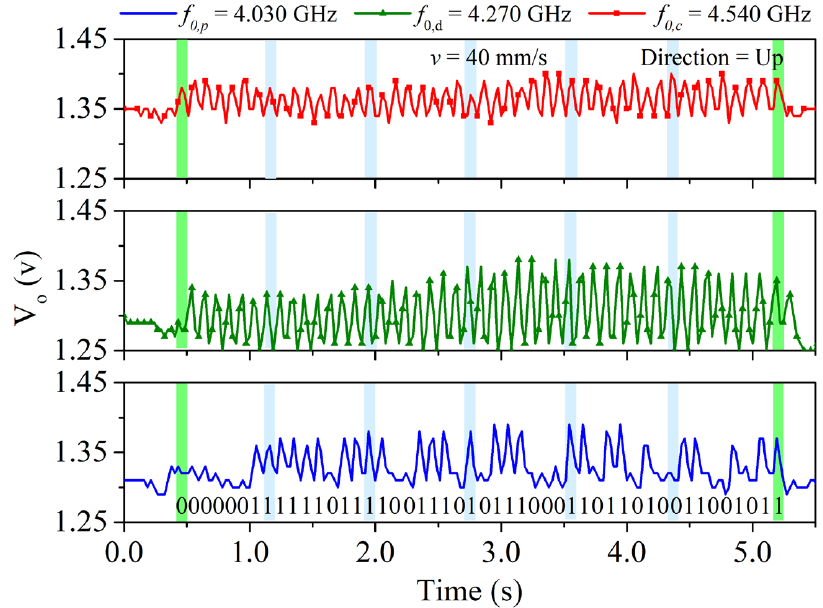
Figure 3. Measured envelope function for the clock, direction, and position signals corresponding to the quasi-absolute encoder system of Figure 2. Reprinted with permission from [11].